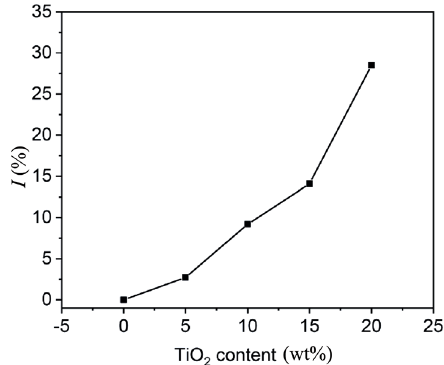
Fig. 7 Effects of TiO 2 content on the relative intensity of Al 2 TiO 5 for the fibers sintered at 1630 ℃ .